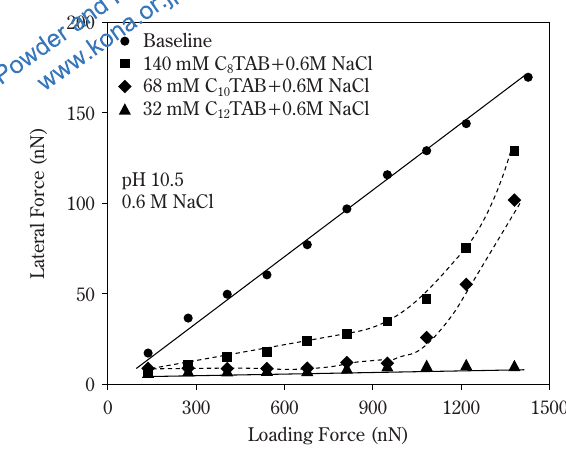
Fig. 3 AFM friction force measurements on silica wafer with 7 µ m size particle attached to the tip. (a) Solutions containing C 12 TAB, C 10 TAB and C 8 TAB surfactants at 32, 68 and 140mM concentrations without NaCl at pH 10.5 in the presence of 0.6 M salt in the solution. Reprinted from Basim et.al. (35) with permission from